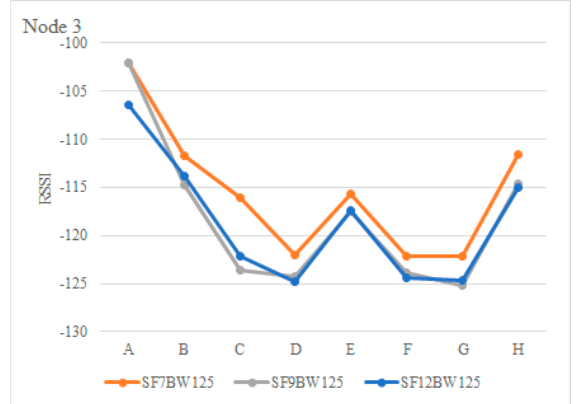
Sensors 2022 , 22 , x FOR PEER REVIEW Figure 15. RSSI of the radio (dBm) of node 3. Figure 15. RSSI of the radio (dBm) of node 3. Figure 15. RSSI of the radio (dBm) of node 3.